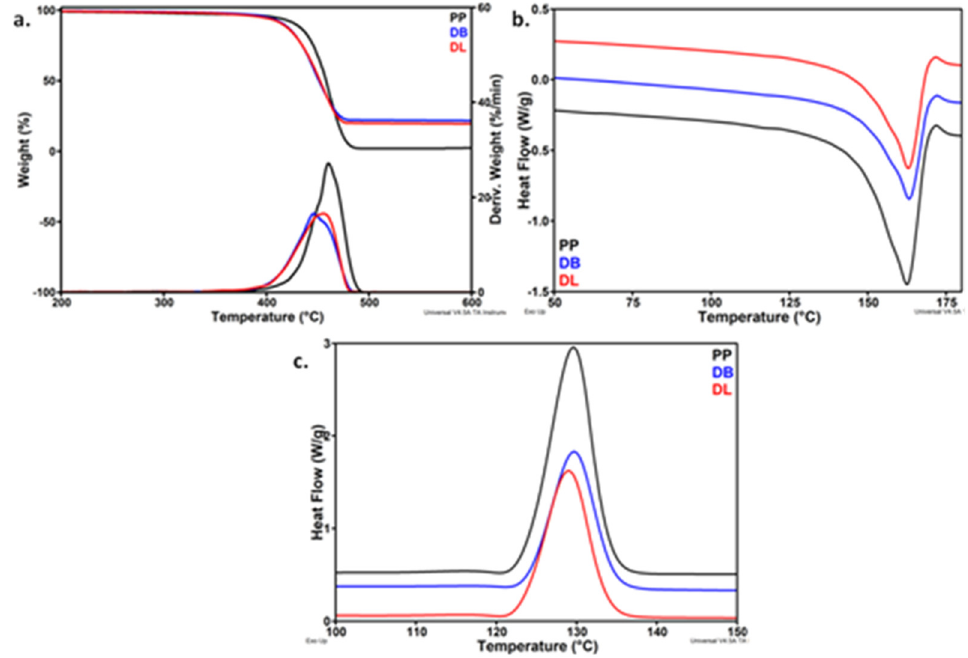
Figure 9. TGA-DTG curves ( a ), DSC heating ( b ) and cooling ( c ) cycles of PP and PP hybrid compo- sites.